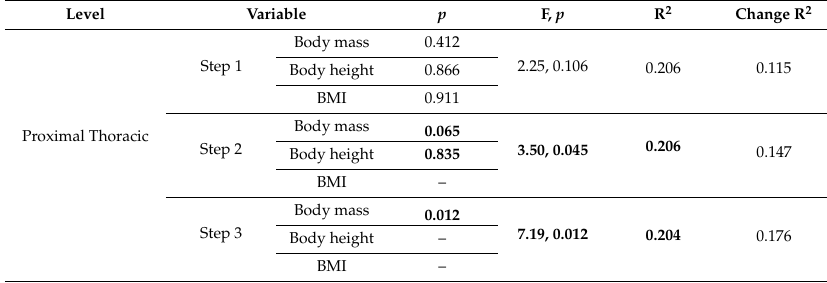
Table 2. The regression analysis predicting the mean of ATR value in girls aged 11 years ( n =